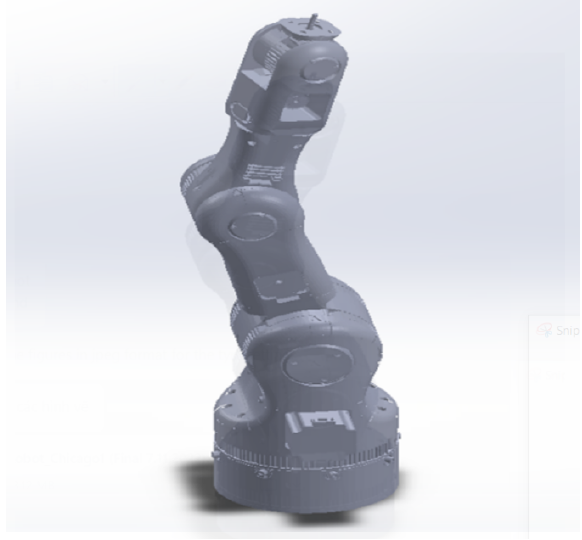
Fig. 1. Robot arm design model according to solid works